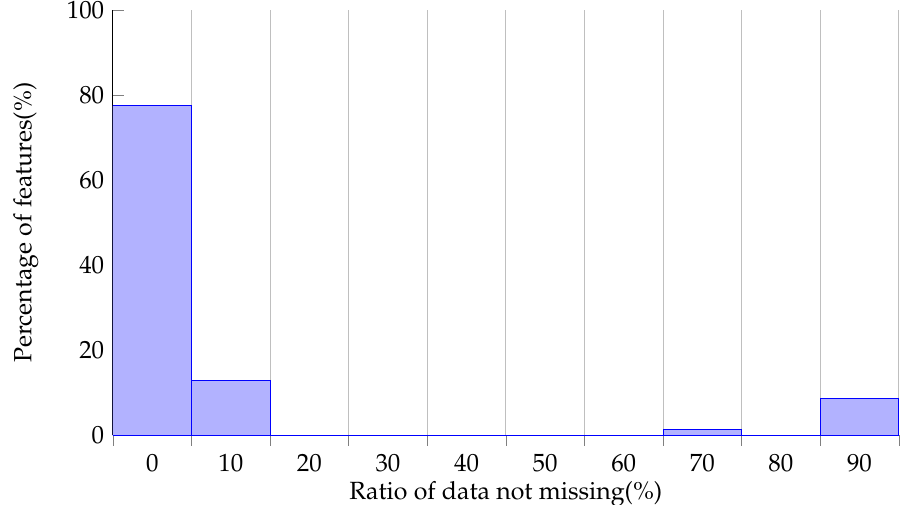
Figure 4. Missing data status on